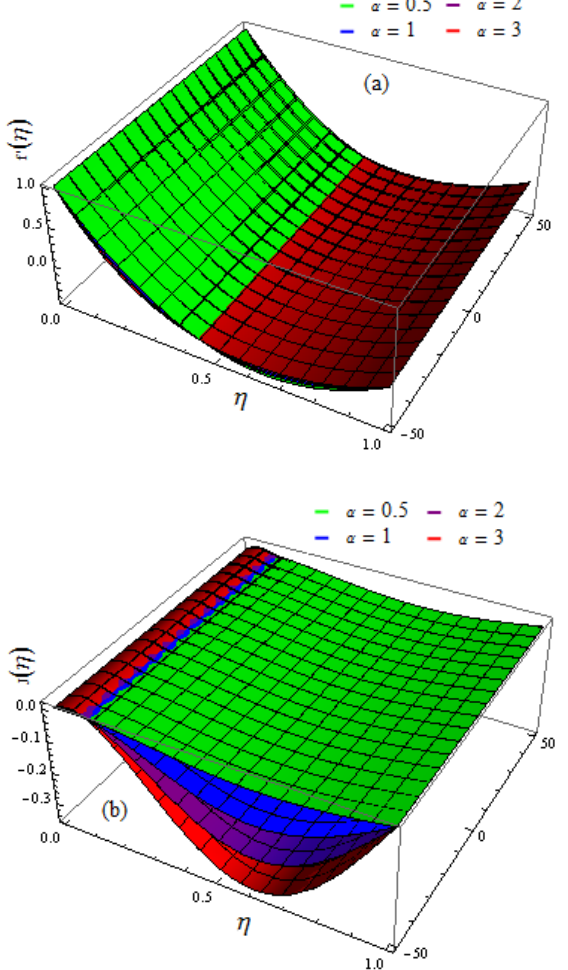
Figure 6. ( a ). Influence of 𝑎 on 𝑓 ′ (𝜂) . ( b ) Influence of 𝑎 on 𝐽(𝜂) .